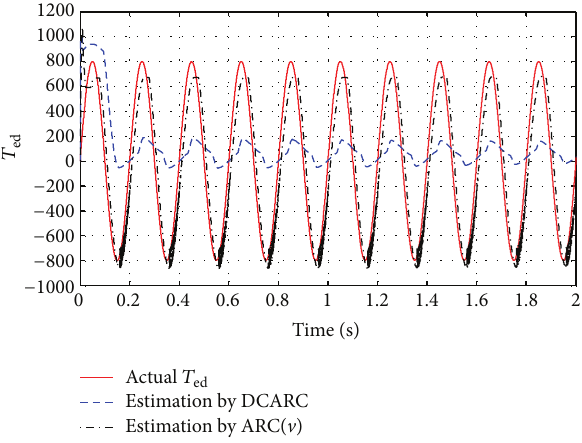
Figure 4: Parameter adaptation in the presence of uncertain nonlinearities.